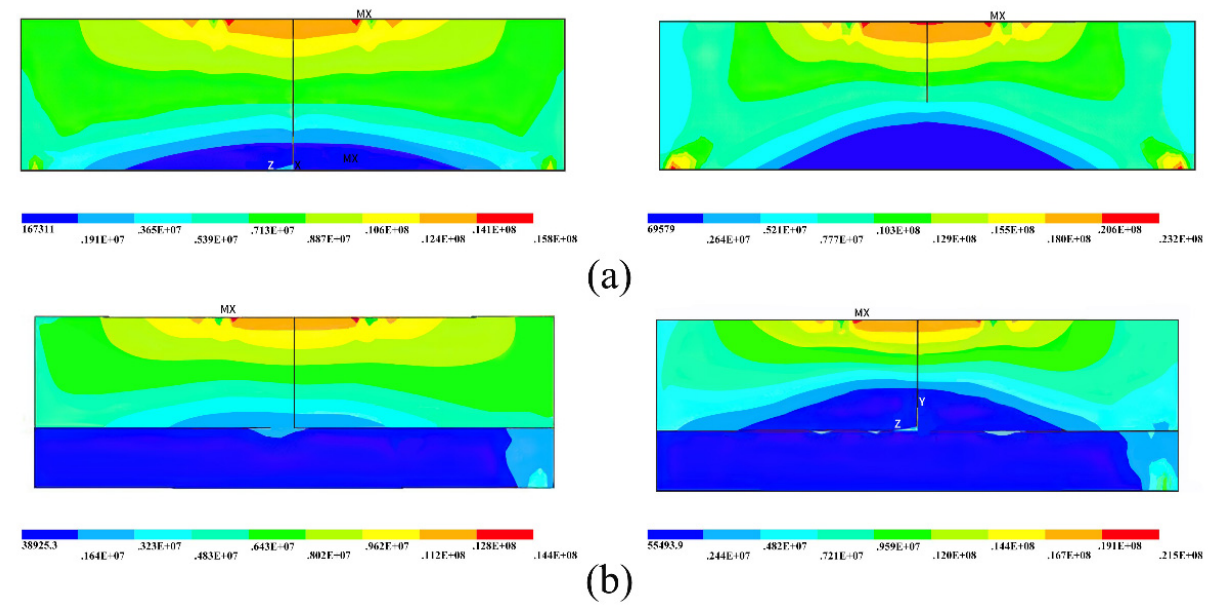
Figure 4. Comparison of the stress failure process between the ( a ) single-layer lining and ( b ) double-layer lining.